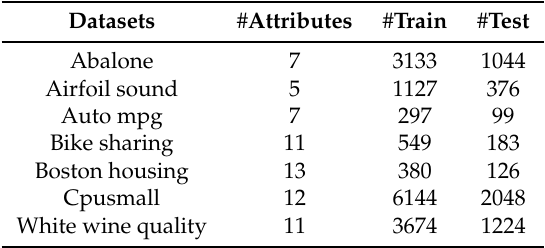
Table 1. Parameters of the regression dataset.